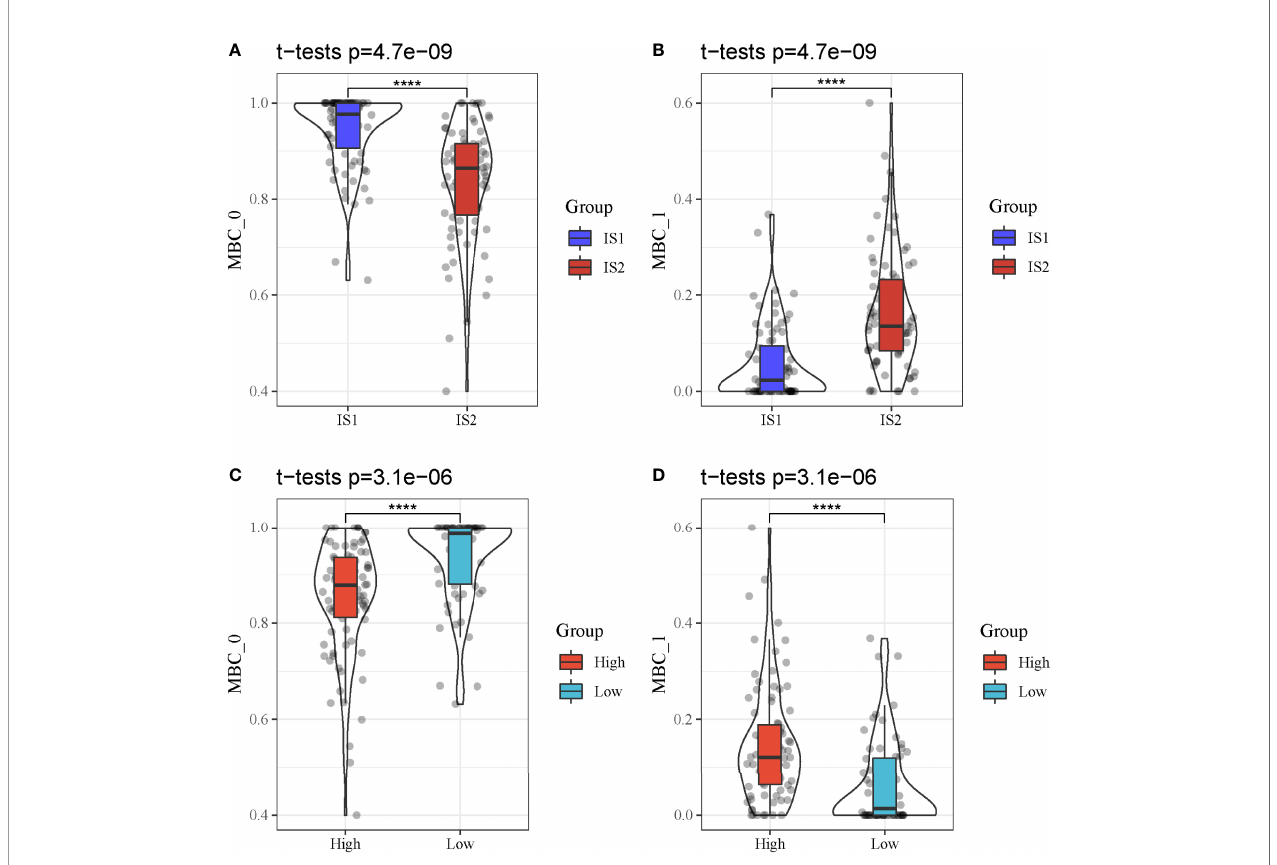
FIGURE 11 | MBC enrichment of different groups in TCGA-PAAD cohort. (A, B) Comparison of the enrichment of MBC_0 and MBC_1 between IS1 and IS2. (C, D) Comparison of the enrichment of MBC_0 and MBC_1 between high-risk and low-risk groups. **** P <